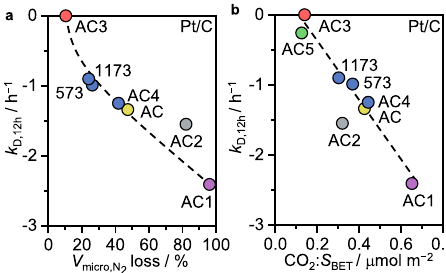
Fig. 4 Stability descriptors for Pt/C catalysts in acetylene hydrochlorination. Correlation between the deactivation constant and ( a ) the loss in total micropore volume, and ( b ) the density of acidic oxygen surface groups, estimated as the total content of oxygen functional groups evolving as CO 2 during TGA-MS, normalized by the surface